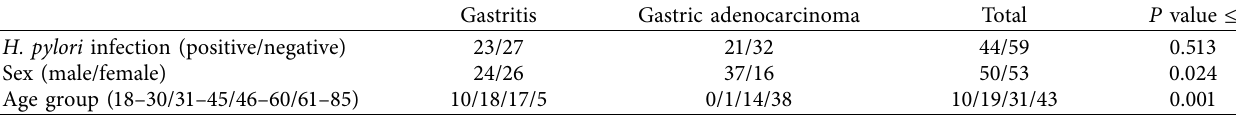
Table 4: Demographic characteristics of patients and correlation of demographic variables.